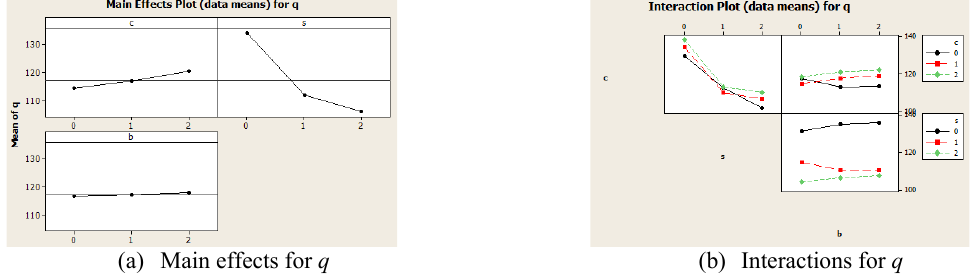
Fig. 3. Main effects and interactions plot for the lot